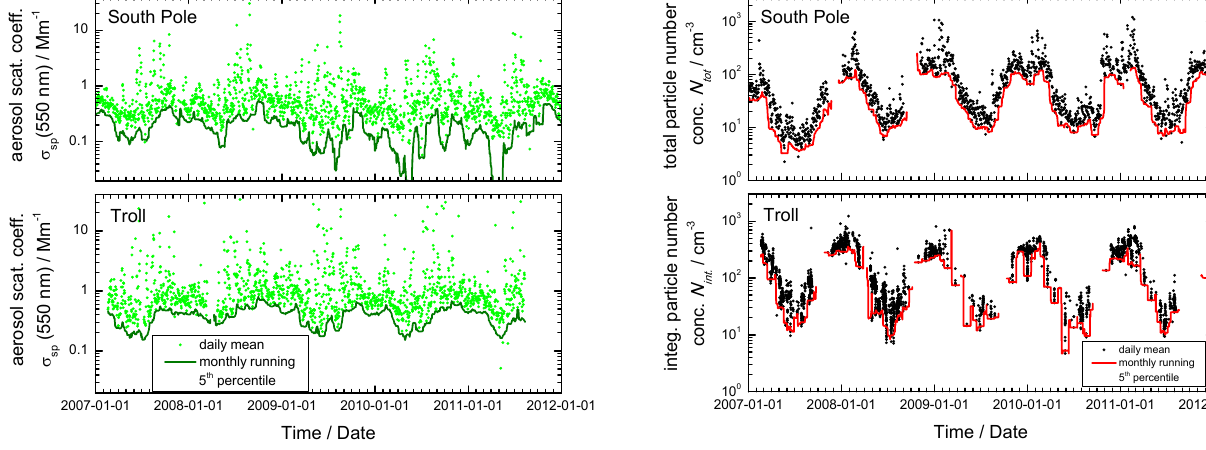
Fig. 2. Time series (2007–2011) of aerosol scattering coefficient Fig.2. Timeseries(2007-2011)ofaerosolscatteringcoefficientdailyaveragesat550nmwavelengthmeasured daily averages at 550nm wavelength measured at the Global At- attheGlobalAtmosphereWatchstationsSouthPole(toppanel)andTroll(lowerpanel). Tohighlighttheannual mosphere Watch stations, South Pole (top panel), and Troll (lower cycleinthebaselinescatteringcoefficientdata,theplotsalsocontaintherunning4-week5thpercentiles,which panel). To highlight the annual cycle in the baseline scattering co- are based on hourly values. efficient data, the plots also contain the running 4-week 5th per- centiles, which are based on hourly values.